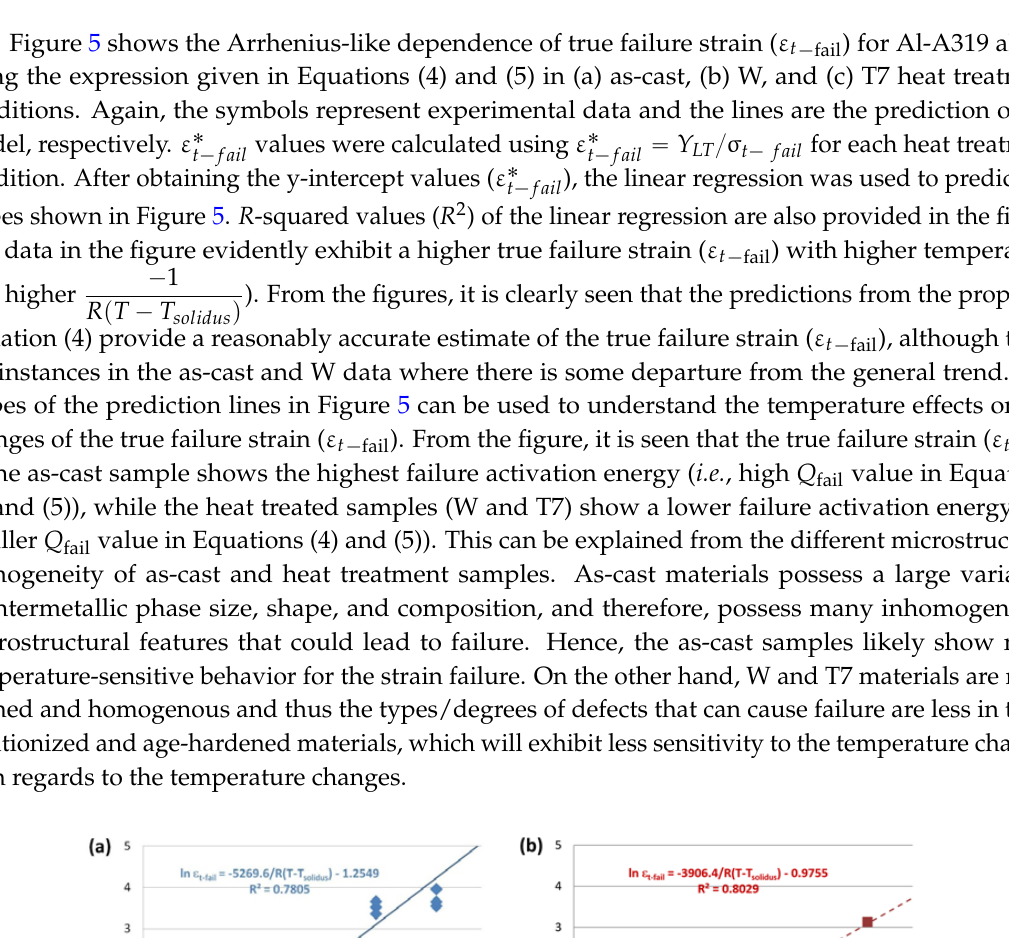
Figure 4. Temperature ‐ dependence of ( a ) true yield stress ( σ t − y ); and ( b ) true failure stress ( σ t − fail ) for Al ‐ A319 alloys in various heat treatment conditions. Symbols represent experimental data and the curves are the prediction of the model, respectively.